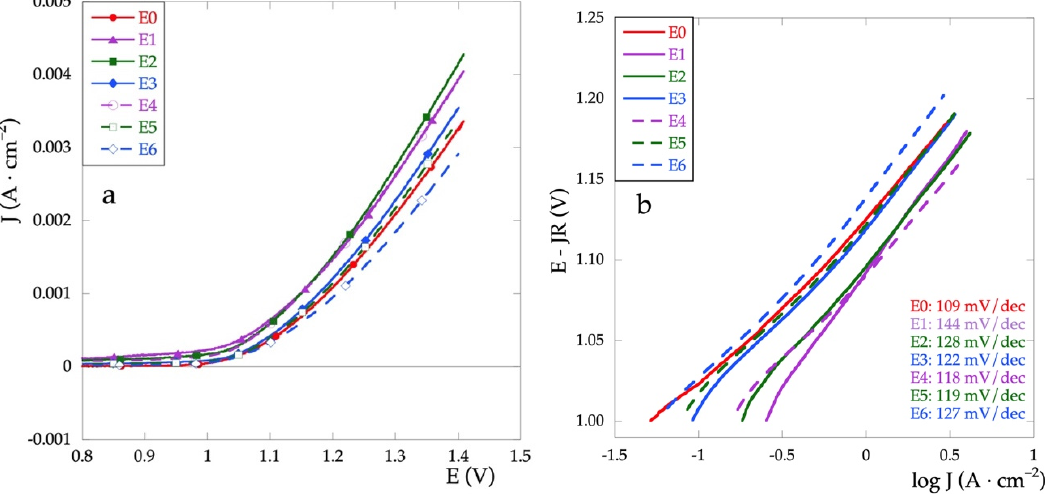
Figure 7. ( a ) Anodic polarization curves and ( b ) Tafel curves recorded in Na 2 SO 4 0.1 mol·L − 1 at v = 5 m·Vs − 1 .